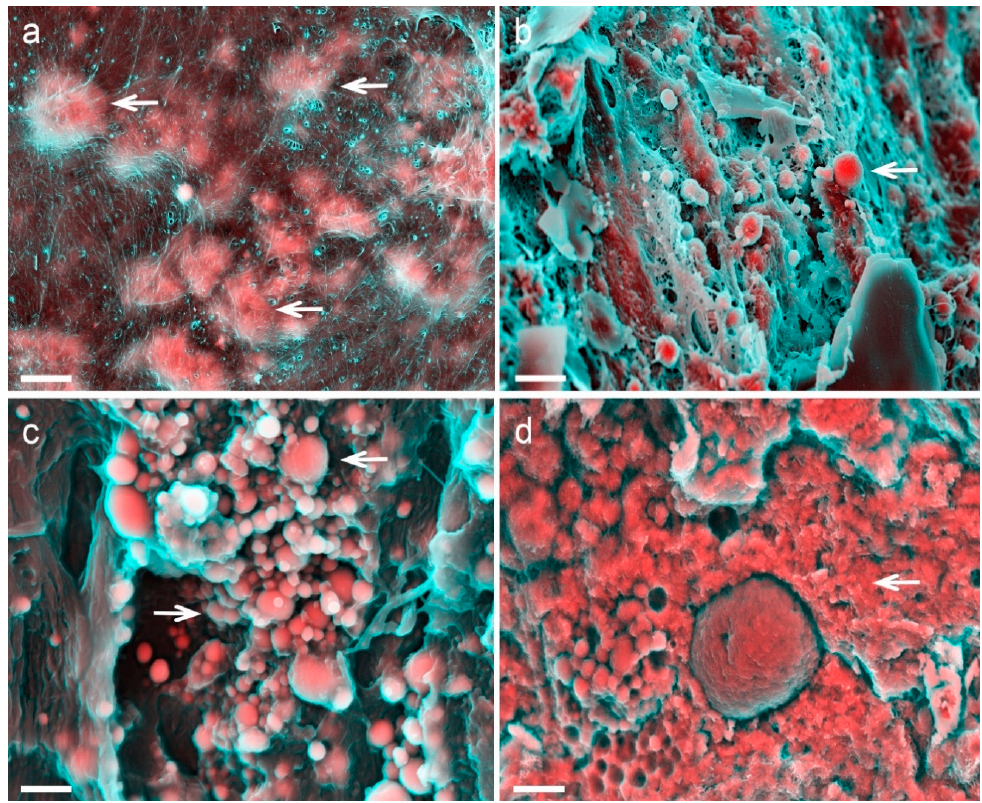
Figure 1. Density-dependent colour-scanning electron micrographs (DDC-SEM) [3] of calcification observed in cardiovascular tissue. Red and pink indicate inorganic and turquoise (blue/green) indicates organic material. ( a ) Calcified fibres indicated by arrows. Scale bar = 2 µm. ( b ) Calcific particles (arrow). Scale bar = 5 µm. ( c ) Aggregates of calcific particles (arrows). Scale bar = 1 µm. ( d ) Large mineral of no defined morphology (arrow). Scale bar = 2 µm. Table 2. List of main questions that remain unanswered in relation to cardiovascular